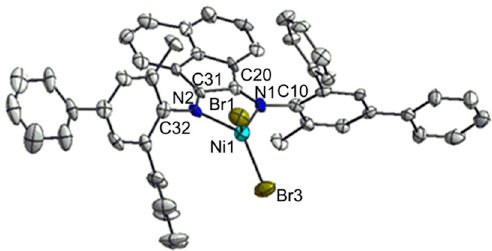
Figure 1. Molecular structure of 3 . H atoms were omitted for clarity. Selected bond lengths (Å) and angles (°): Br1–Ni1 2.329(3), Br3–Ni1 2.335(18), Ni1–N1 2.036(6), Ni1–N2 2.017(6), N1–C20 1.298(8),